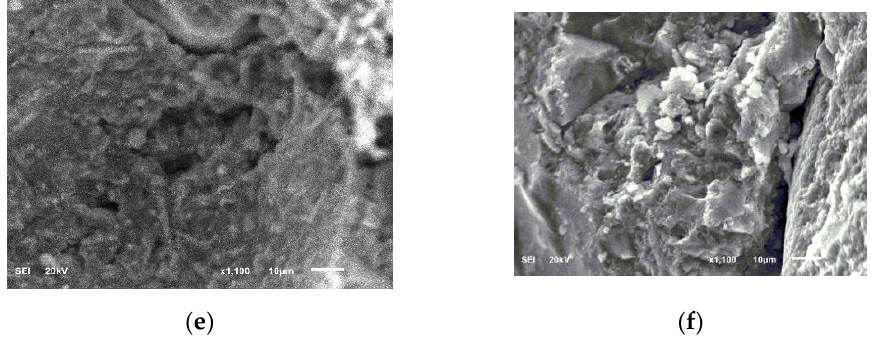
Figure 8. SEM images of MKPC mortar samples and P.O mortar samples. ( a ) M1, before freeze– thaw; ( b ) M1, after 200 freeze–thaw cycles in water solution; ( c ) M1, after 200 freeze–thaw cycles in 5% Na 2 SO 4 solution; ( d ) M2, before freeze–thaw cycles; ( e ) M2, after 50 freeze–thaw cycles in water solution; ( f ) M2, after 50 freeze–thaw cycles in 5% Na 2 SO 4 solution. A–C are EDS analysis of corresponding areas, see Table 3 for details. Table 3. Micro-area element distribution of MKPC mortar samples.